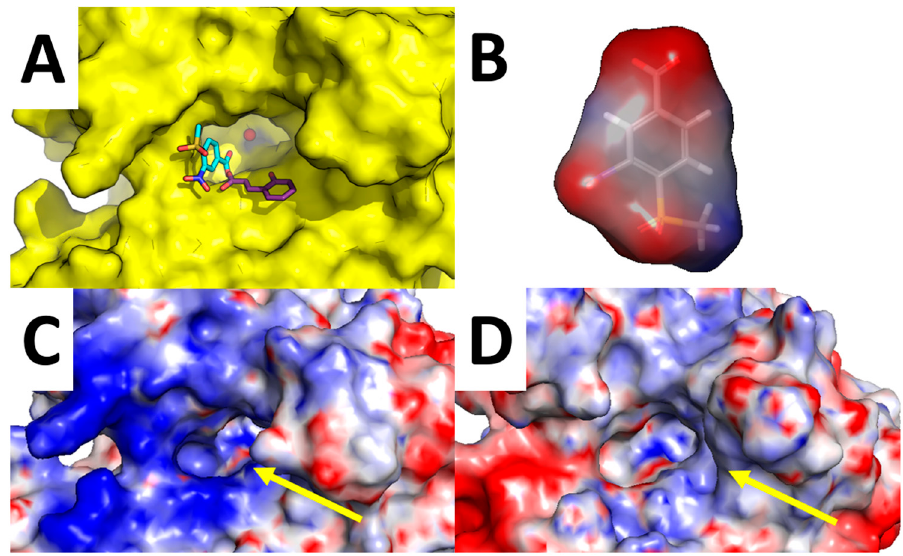
Figure 5. Analysis of compound 7 binding mode. Surrounding of hCA XII Zn(II) binding cavity (highlighted by a yellow arrow) with compound 7 predicted binding-mode and crystallographic hydrolyzed thiocoumarin binding mode ( A ); Surface electrostatic potential of compound 7 ( B ); hCA XII ( C ); and hCA IX ( D ).